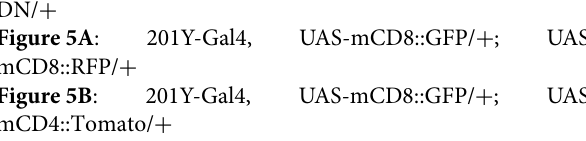
Figure 6 : hsFLP, UAS-mCD8::GFP/ + ;GMR82G02-Gal4, UAS- mCD8::RFP, FRT40A, Gal-80/ FRT40A Generation of MARCM